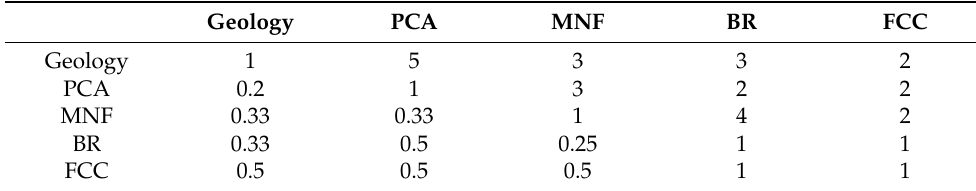
Table 4. The matrix of two-by-two criteria